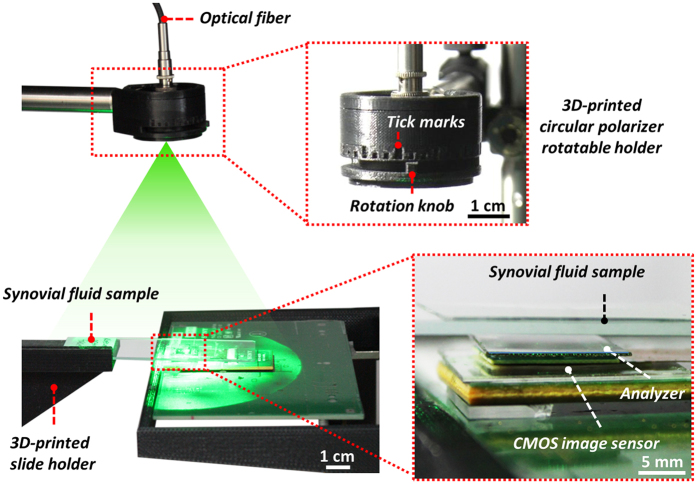
Experimental setup.